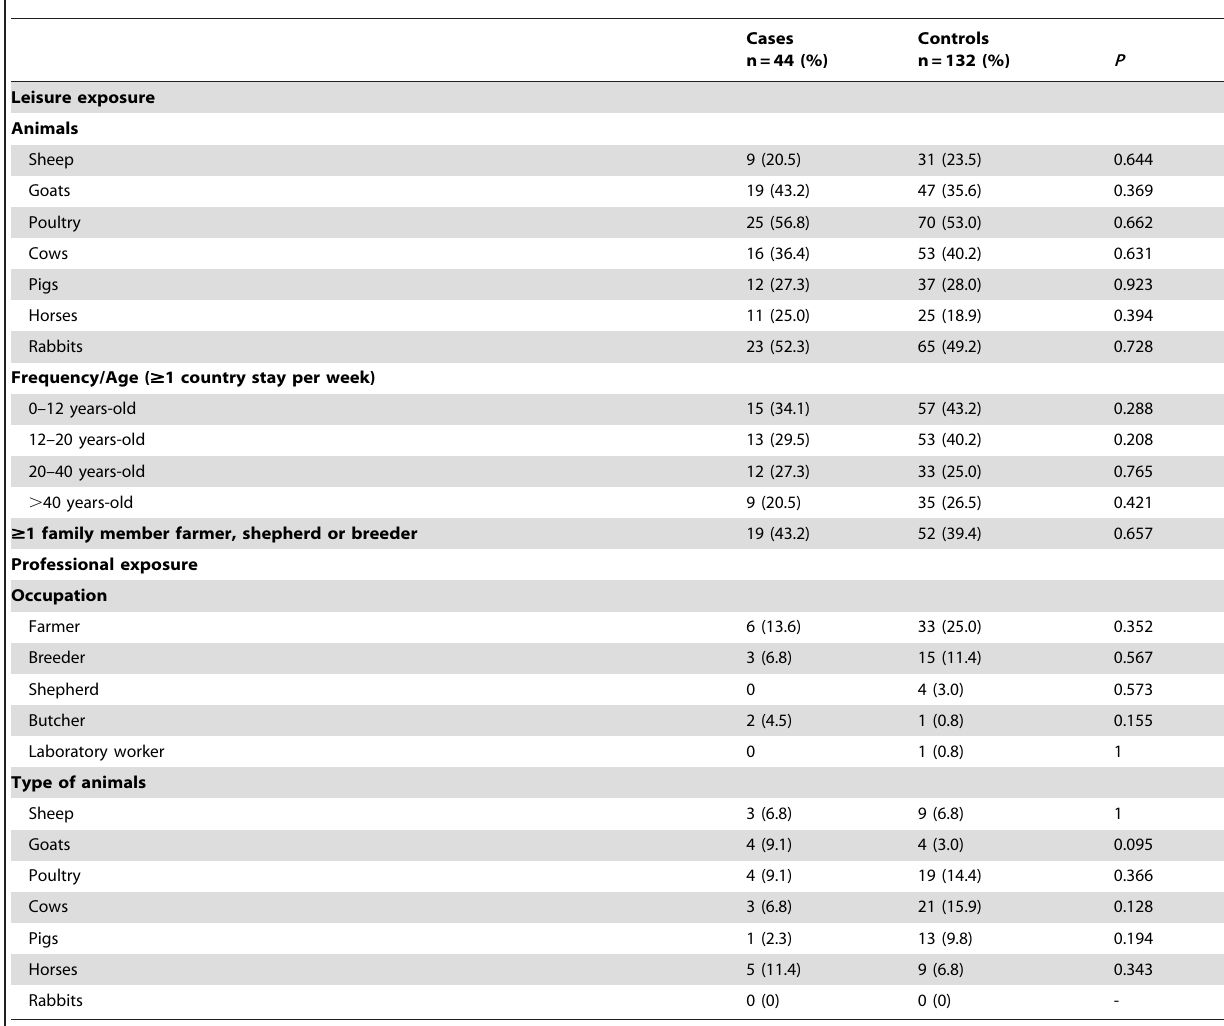
Table 2. Exposure to livestock in the study